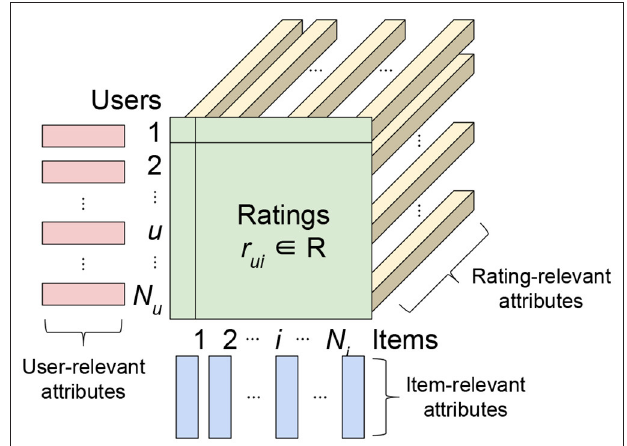
FIGURE 1 | Interpretation of inputs, including ratings and attributes, in attribute-aware collaborative filtering-based recommender systems.